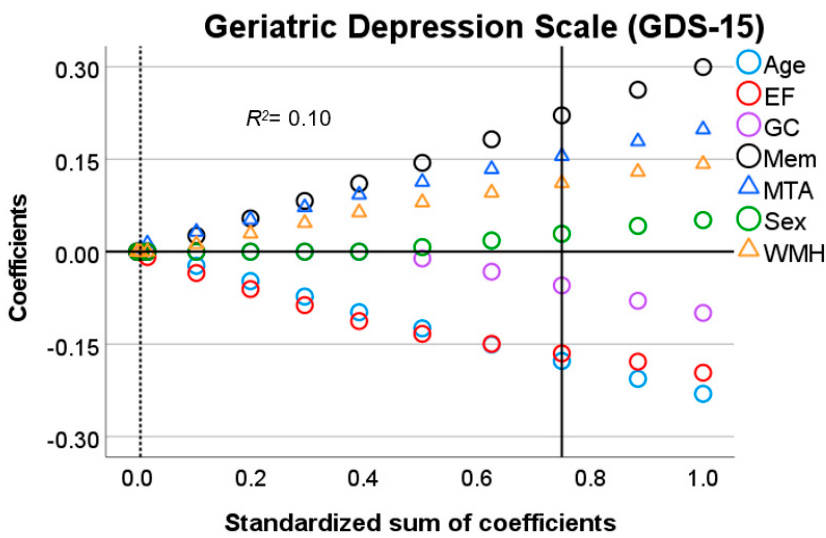
Figure 5. Output chart Lasso regression (Model 3). Input predictors are displayed in alphabetical order but were introduced as follows: sex, age, executive function (EF), global cognition (GC), memory (Mem), white matter hyperintensities (WMH), and medial temporal atrophy (MTA). Identified predictors are sex, age, EF, GC, Mem, WMH, and MTA. Lasso coefficients (colored rings) represent positively and negatively related predictors above and below zero, respectively (y–axis). Vertical lines intersect the Lasso coefficients ( ≠ 0) from the most parsimonious predictors (dotted line) and the optimal predictors (solid line) as computed in the model. In each subfigure, the values of the x–axis represent the relative influence of all the parameters over the dependent variable before shrinkage (standardized sum of coefficients = 1.0 minus shrinkage = 0, which is equal to 1.0 on the right side). At each stage of shrinkage (increasing from right to left in the x–axis), a higher penalty is added until the standardized sum of coefficients is at its lowest (i.e., 0) and shrinkage is at its highest (i.e., 1.0). The smallest prediction error is represented by the solid line tangential to the corresponding shrinkage stage. The predictors with still meaningful associations ( ≠ 0) at such a stage are considered optimal predictors with Lasso coefficients marked in the y–axis. Regularization-R 2 is displayed on the top-left corner of the plot.